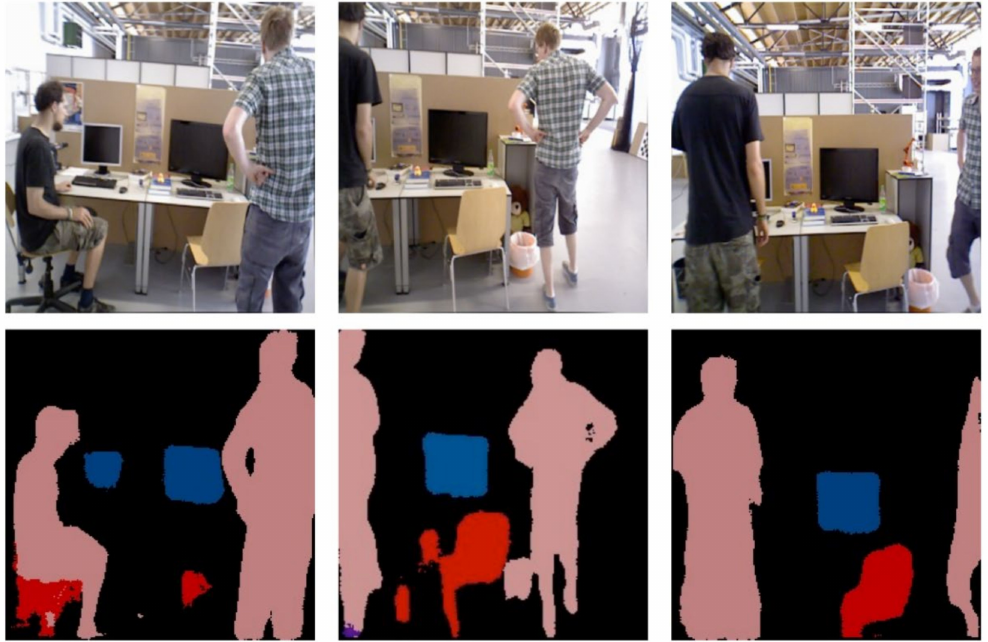
Figure 7. The result of semantic segmentation on the TUM dataset.